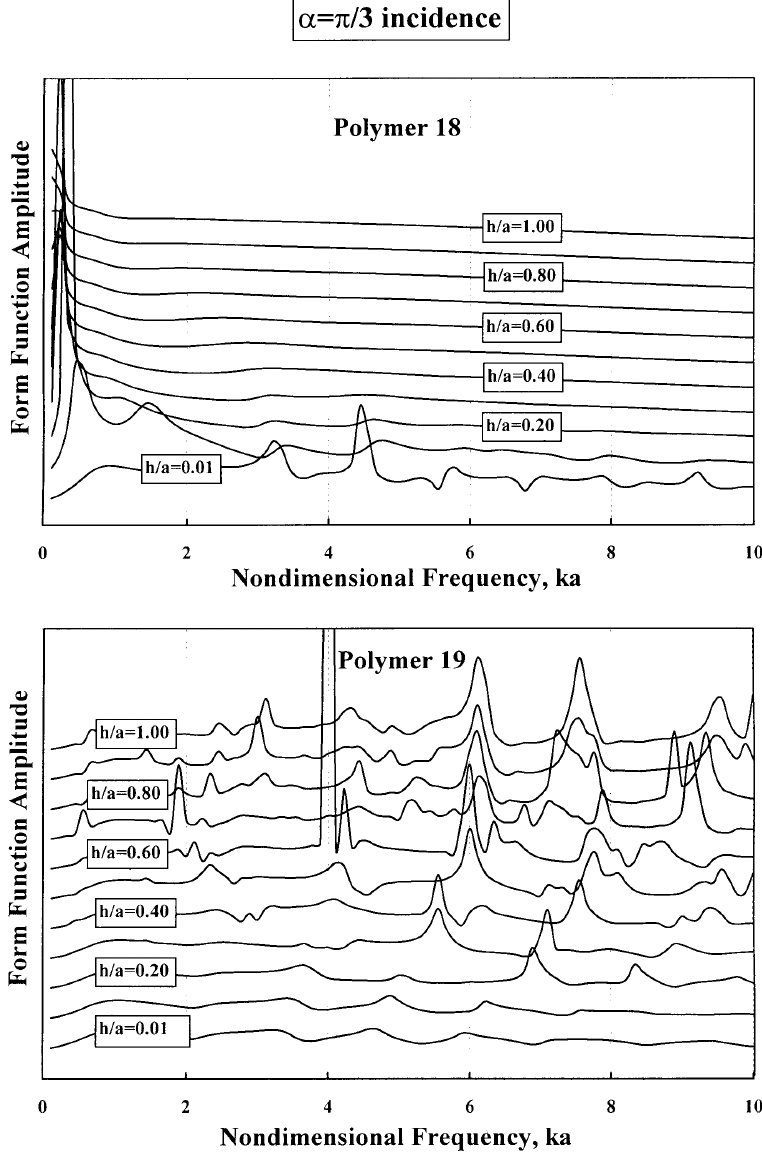
Fig. 10. Variation of the form function for the fluid-filled cylindrical viscoelastic shell with the shell thickness at oblique wave incidence ( α = π/ 3